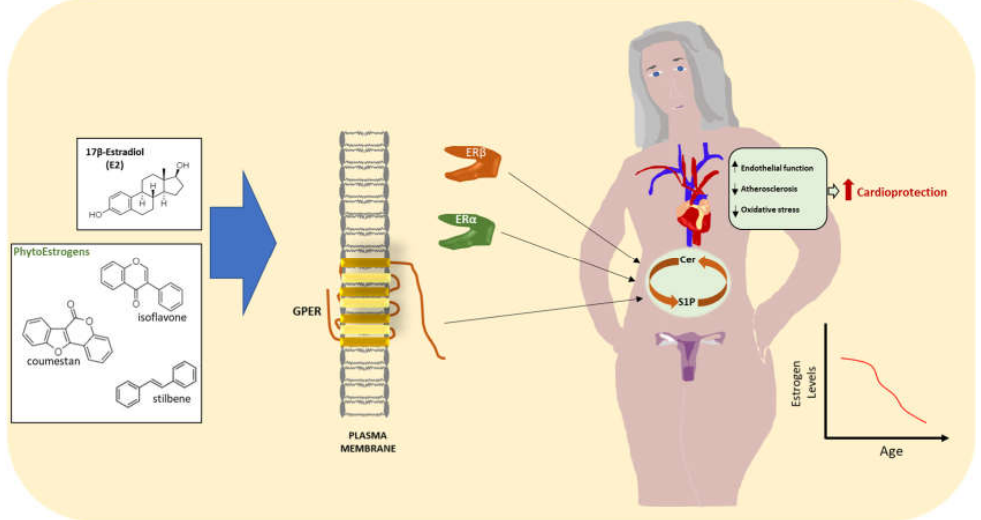
Figure 2. Potential effects of 17β-estradiol (E2) or phytoestrogen (PhE) therapy in postmenopausal women. E2 and PhEs bind to ERs and GPER, thus preserving Cer/S1P rheostat with a consequent beneficial effect on the cardiovascular system. The chemical structures were produced on https://chemdrawdirect.perkinelmer.cloud/js/sample/index.html, accessed on 1 January